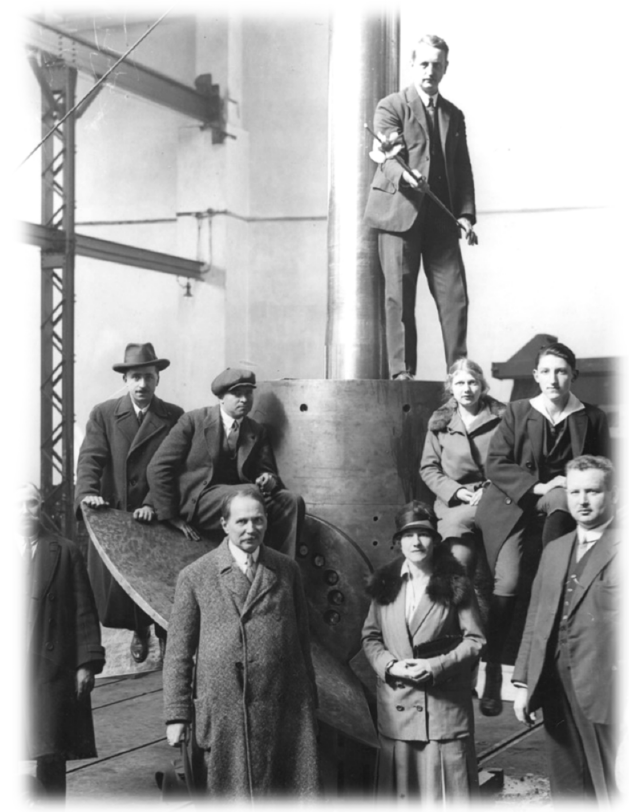
Figure 15. Viktor Kaplan with his closest ones. Source: